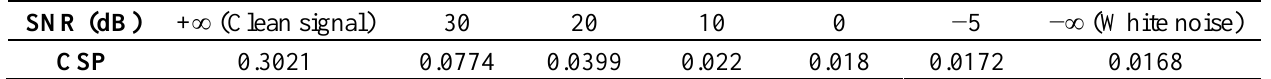
Table 1. The relationship between the CSP and the SNR.